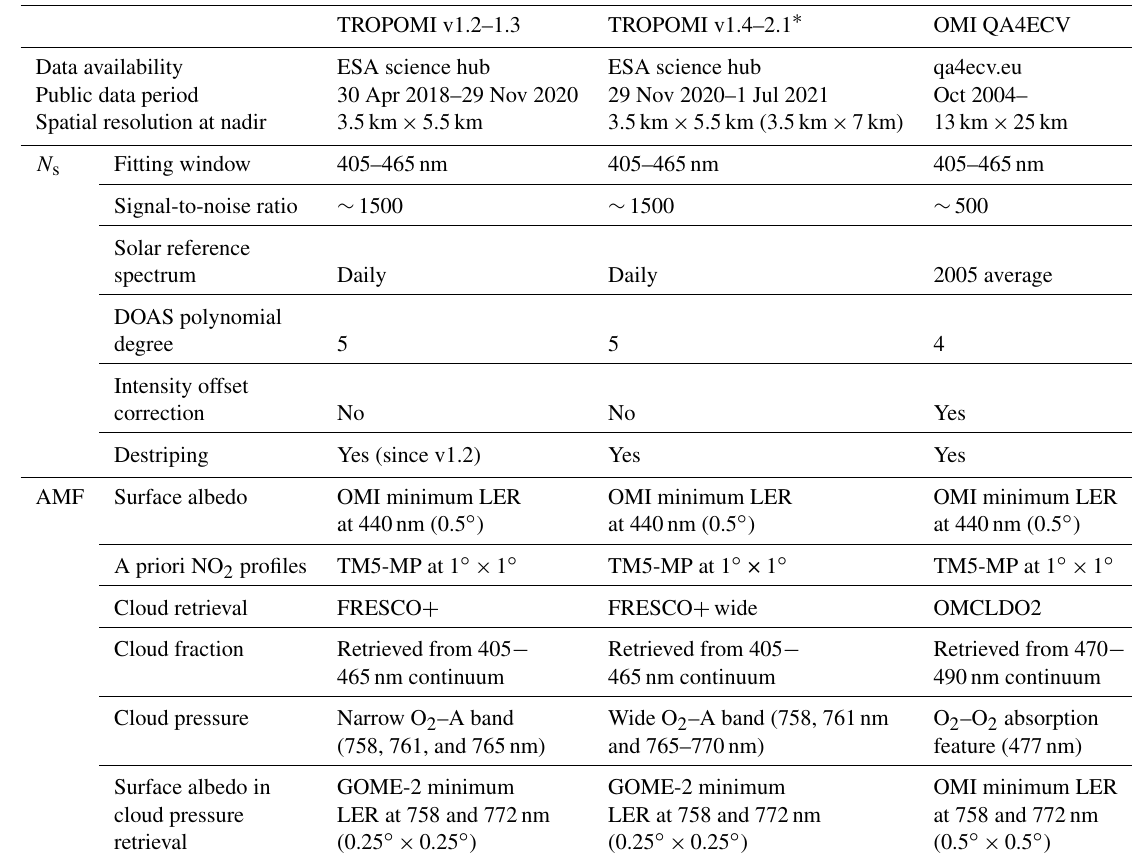
Table 1. Retrieval settings for the TROPOMI and OMI NO 2 retrievals used in this